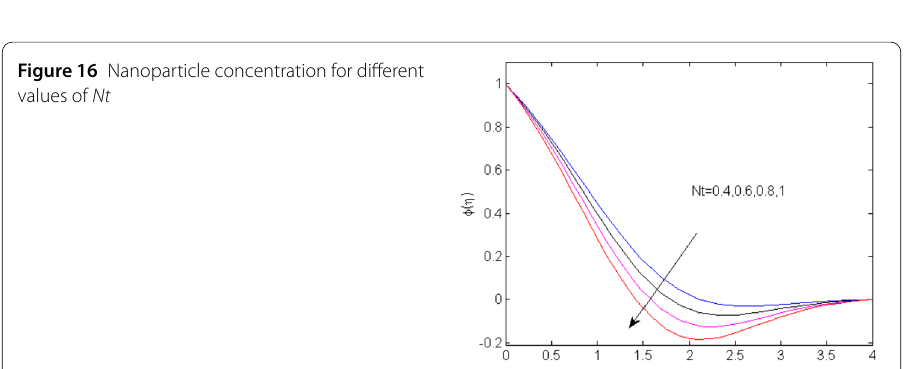
Figure 16 Nanoparticle concentration for different values of